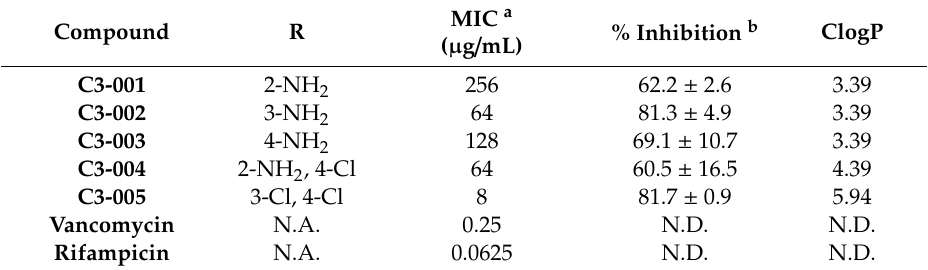
Table 2. Antimicrobial and inhibitory activities of C3 derivatives.